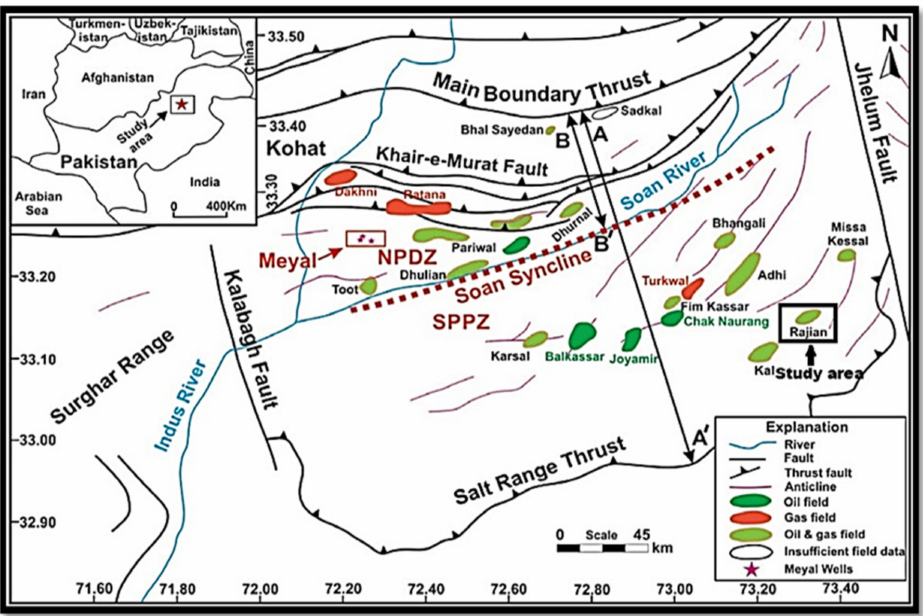
Figure 1. Regional tectonic setting of Rajian area